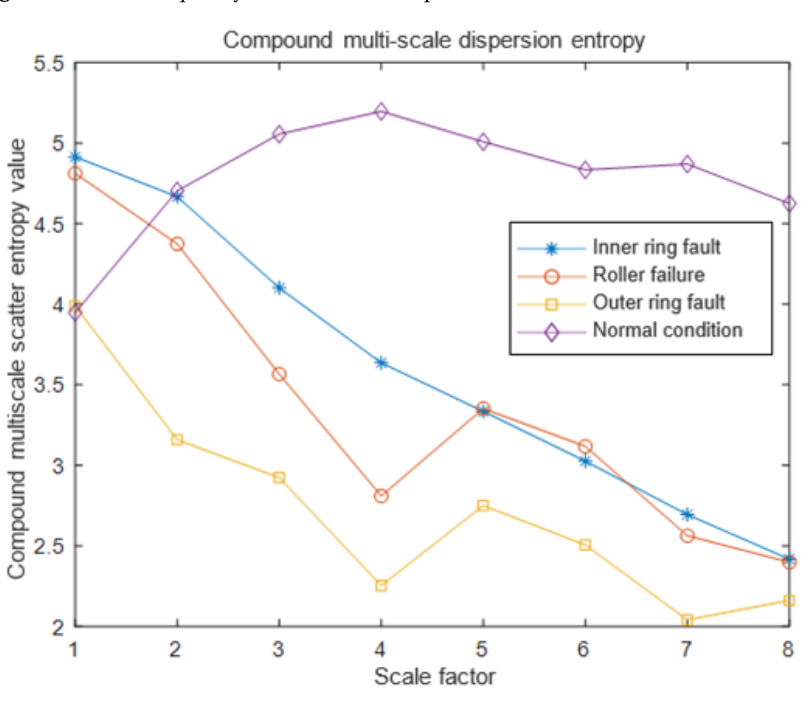
Figure 4. VMD-CMDE at τ = 8. From the calculation formulas of multi-scale dispersion entropy and composite multi- scale dispersion entropy, it can be seen that five parameters need to be selected. They are the length N of the sequence, the embedding dimension m, the number of categories c, the time delay d and the scale factor τ . In this paper, the length n = 1024, the embedding dimension m = 3, the number of categories c = 6, the time delay d = 1, and the scale factor are selected through simulation analysis. Figures 4–6 show a random point entropy curve corresponding to scale factors 8, 10, and 12,